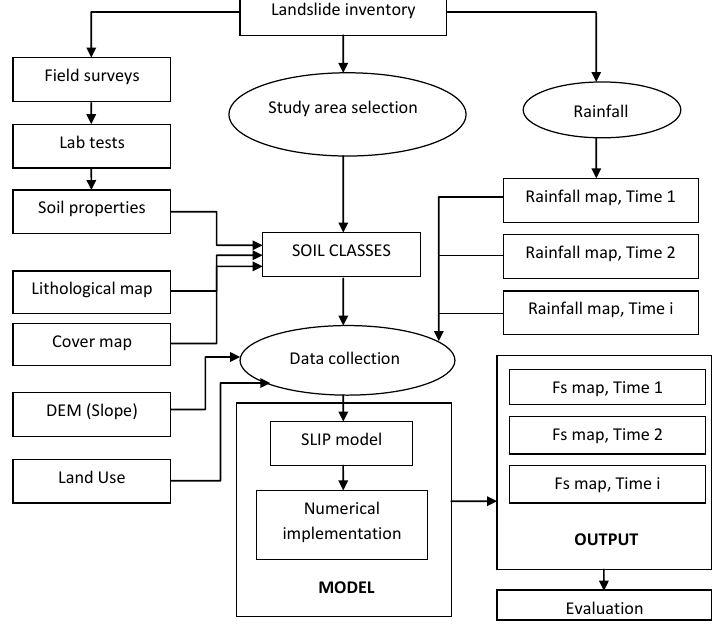
Fig. 7. Flow chart representing the conceptual methodology of the SLIP model for the slope-stability analysis on a regional scale.